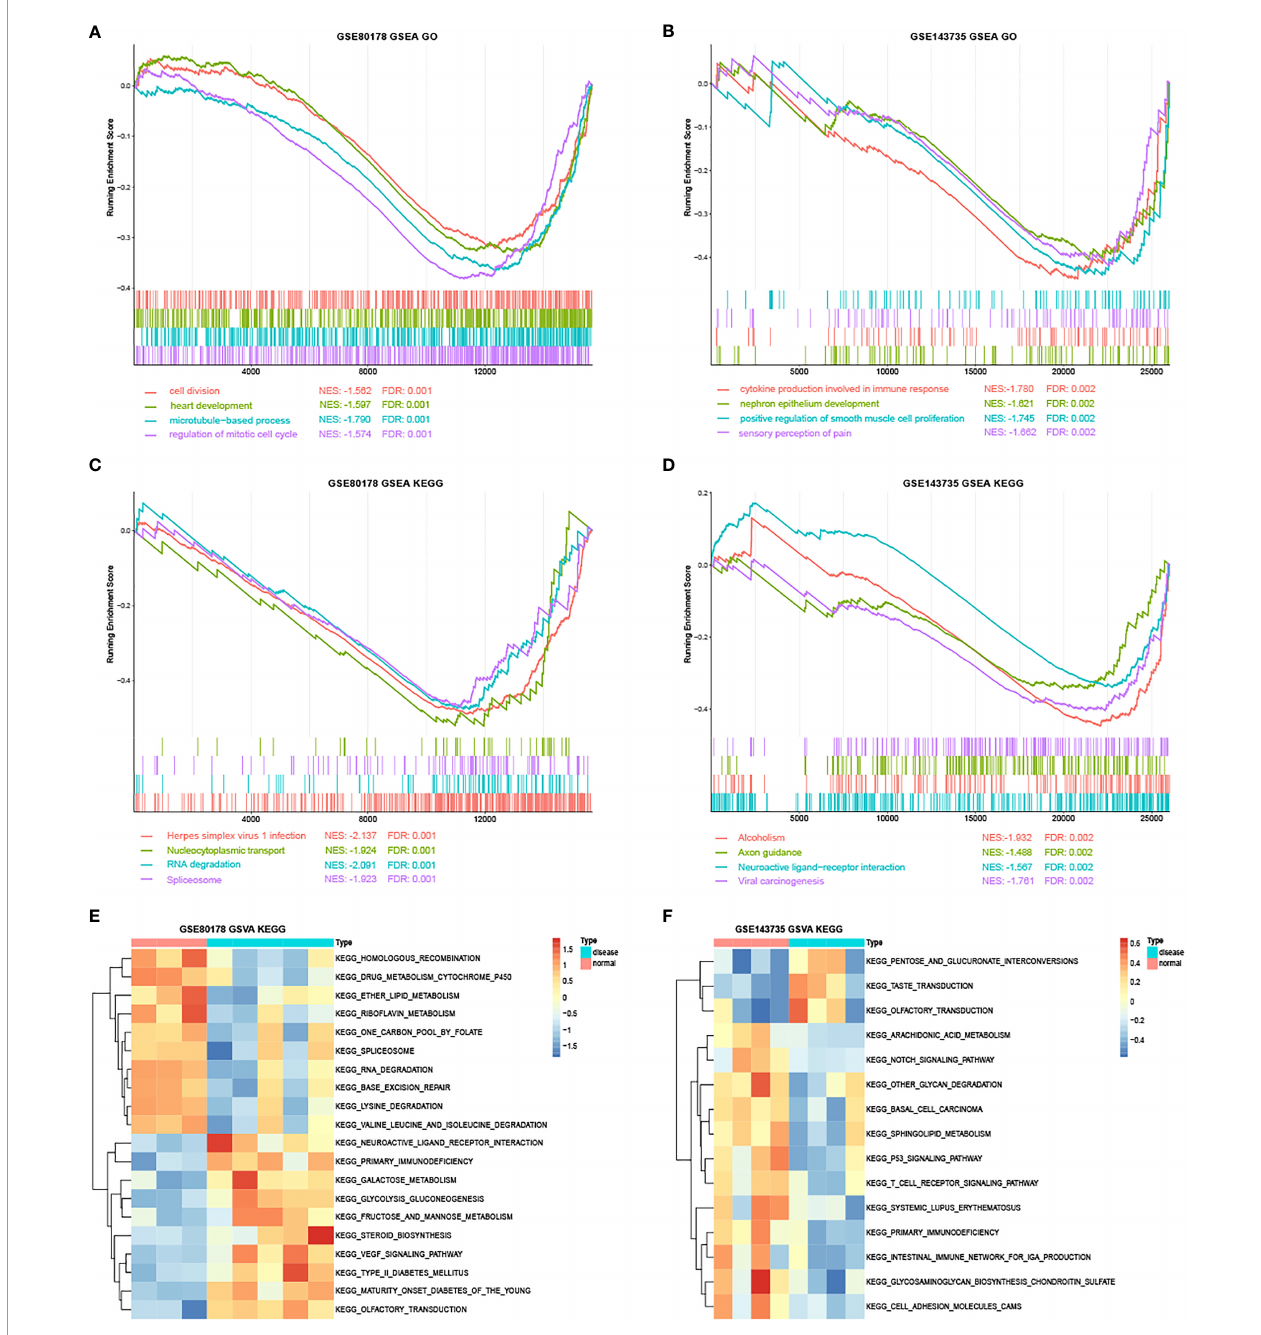
FIGURE 5 | The GSEA and GSVA analysis in GSE80178 and GSE143735. (A) Top four GO annotations with a P-value in GSE80178 through GSEA analysis. (B) Top four GO annotations with a P-value in GSE143735 through GSEA analysis. (C) Top four KEGG pathway with a P-value in GSE80178 through GSEA analysis. (D) Top four KEGG pathway with a P-value in GSE143735 through GSEA analysis. (E) Top 20 KEGG pathway with a P-value in GSE80178 through GSVA analysis. (F) Top 20 KEGG pathway with a P-value in GSE143735 through GSVA